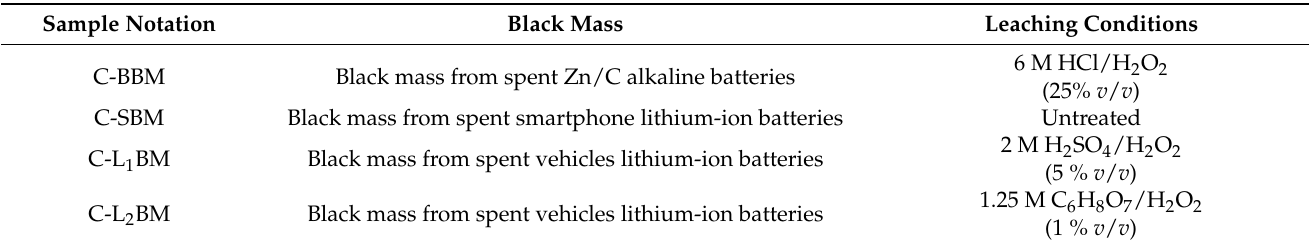
Table 1. Samples notation and obtaining conditions for the investigated